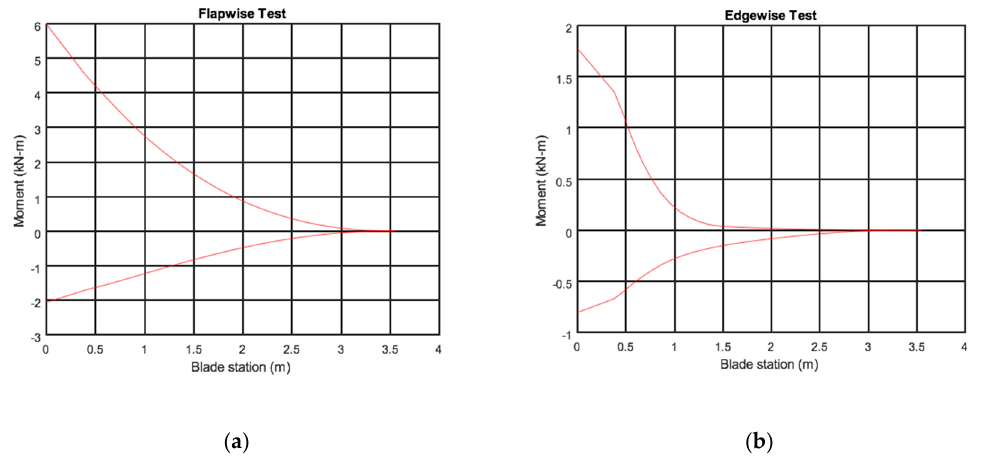
Figure 6. The design loads: ( a ) flapwise direction and ( b ) edgewise direction.